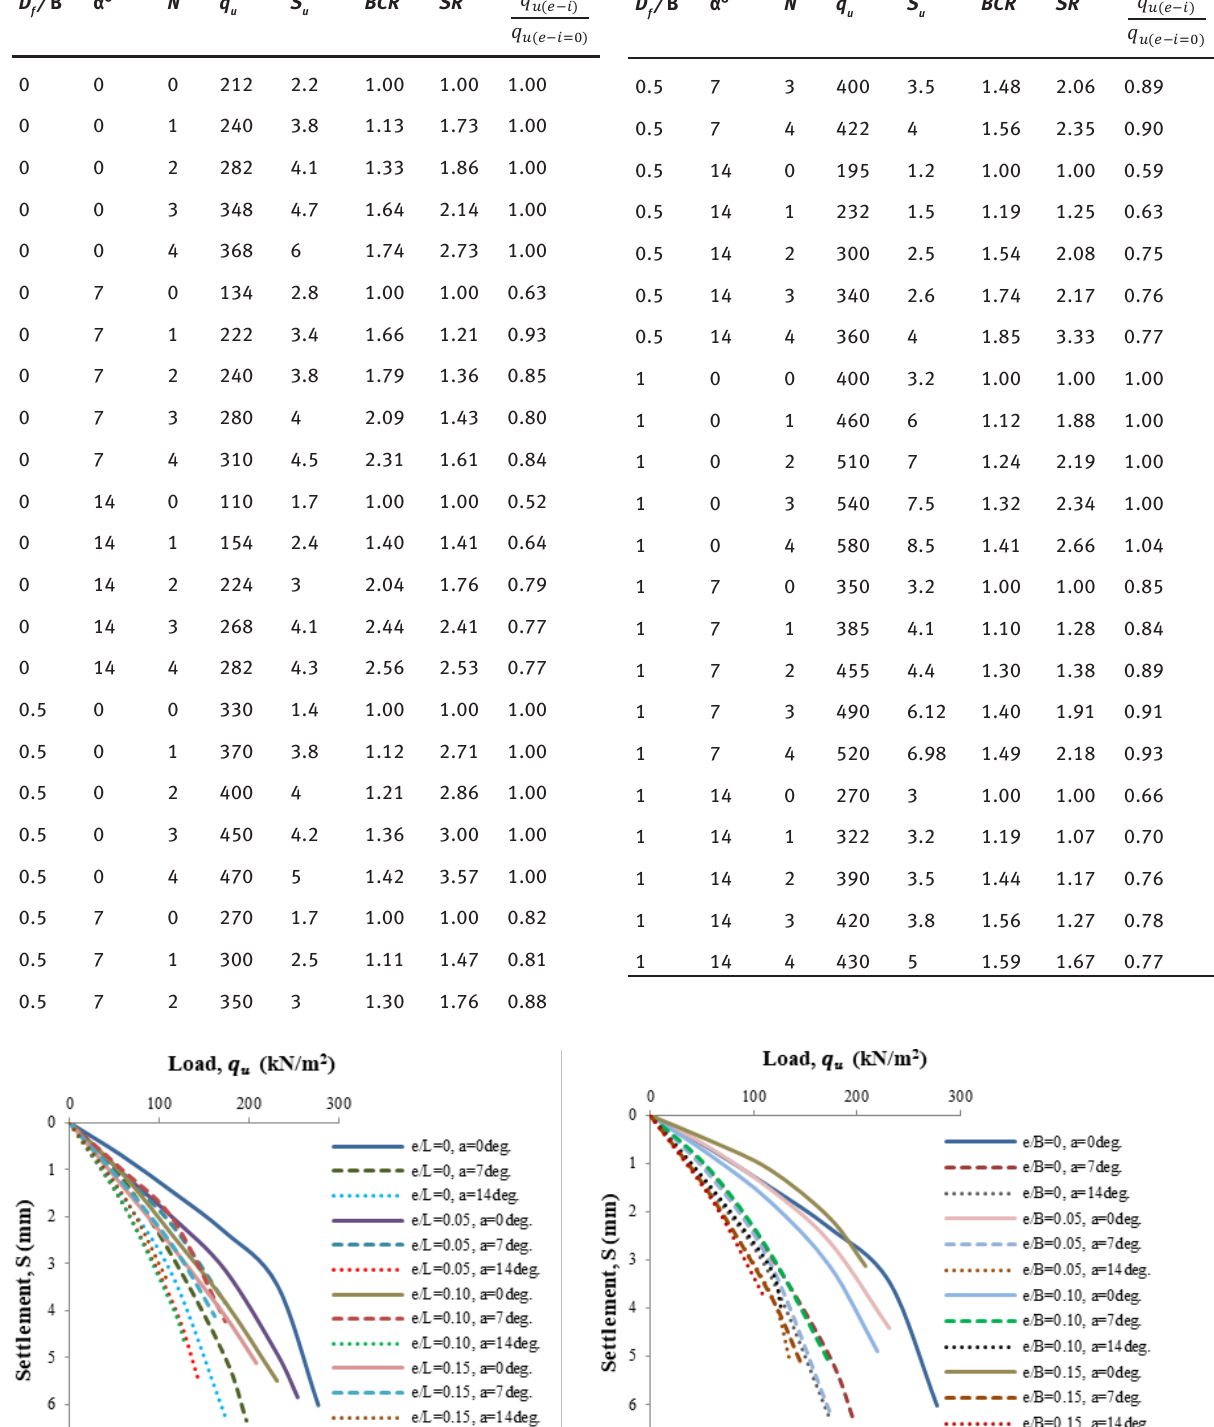
Table 4: Results of rectangular footing subjected to inclined loading (a°) in unreinforced and reinforced sand conditions. ⁄ B D f